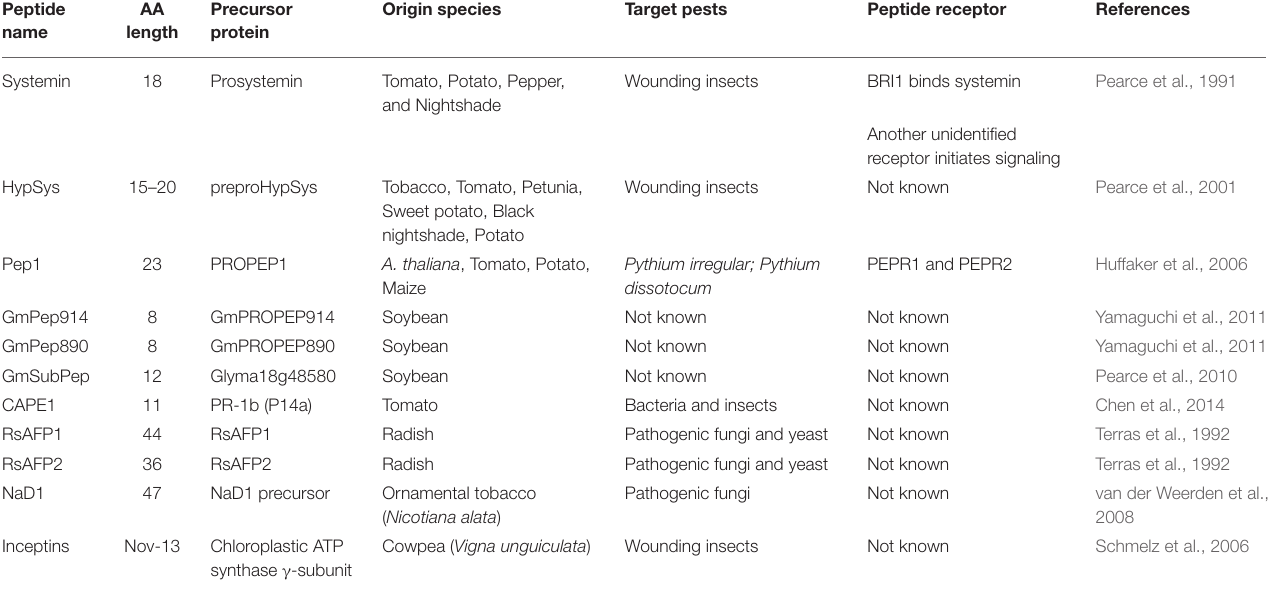
TABLE 1 | Plant ribosomal